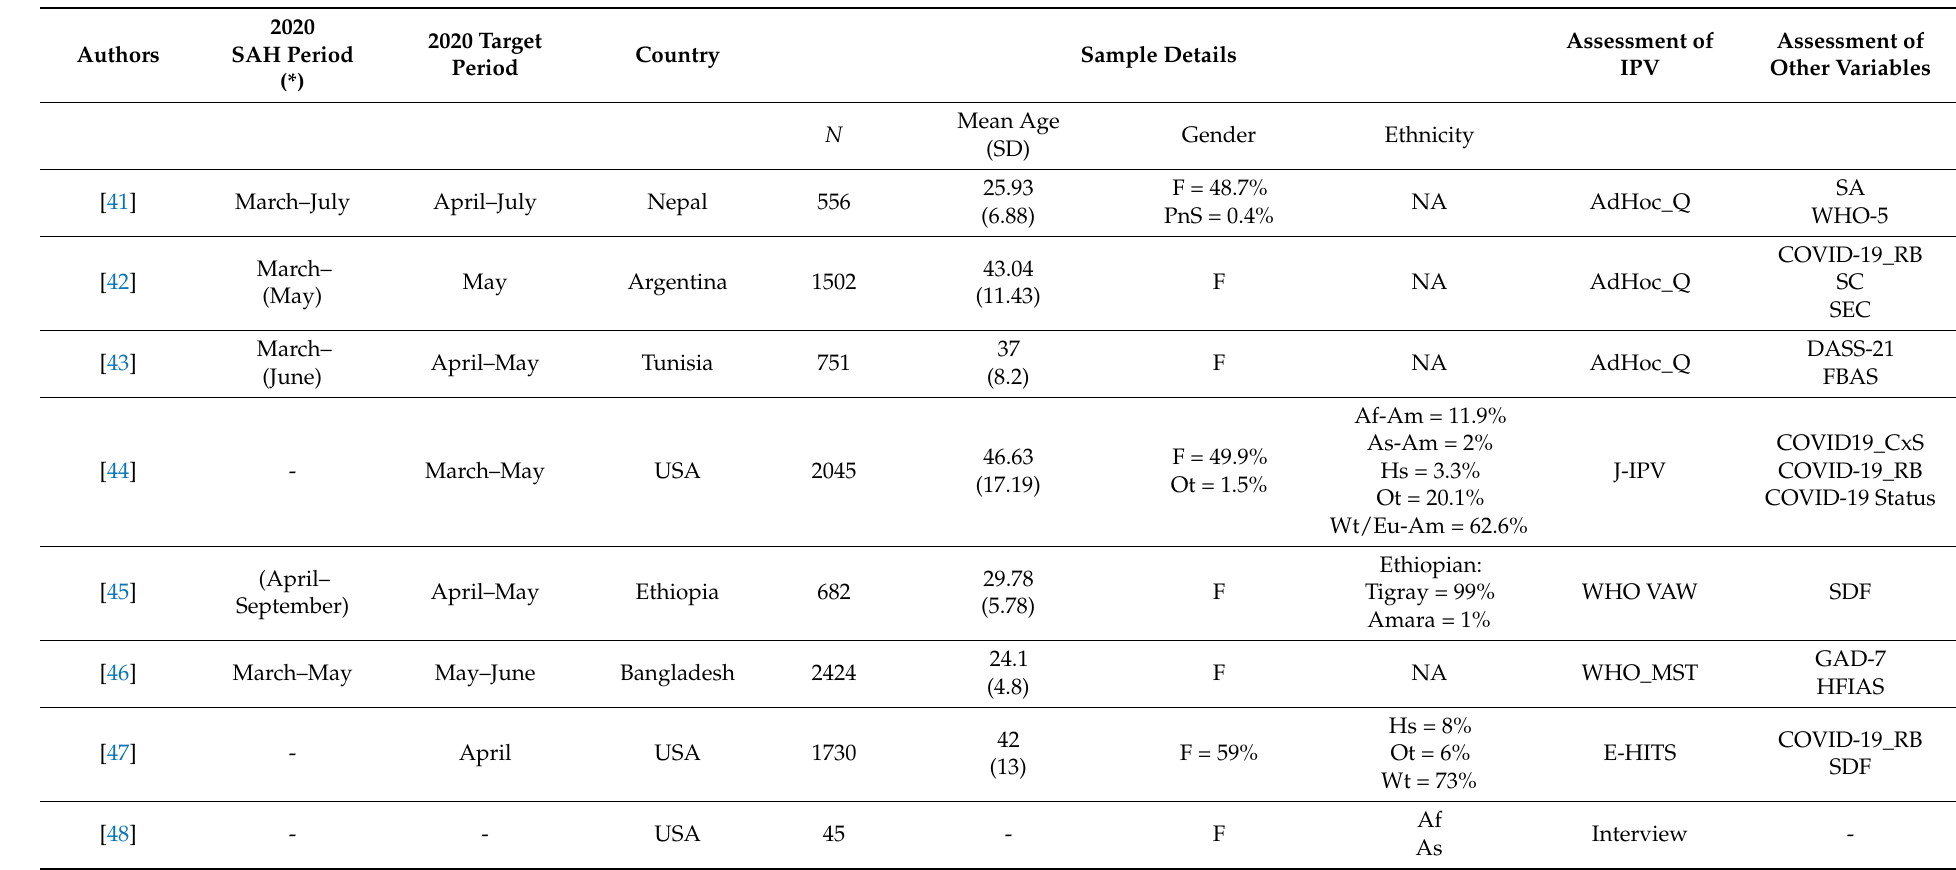
Table 3. Coding Victim